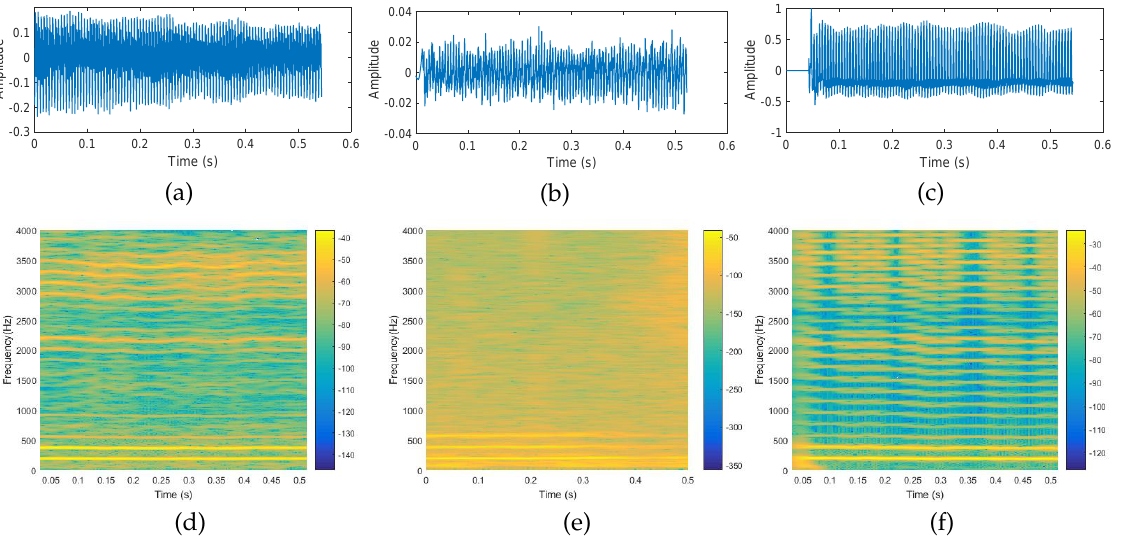
Figure 10. Speech recovery results for the English letter “A”. ( a ) Waveform of the original speech signal; ( b ) waveform of the radar signal; ( c ) waveform of the synthesized speech signal; ( d ) spectrogram of the original speech signal; ( e ) spectrogram of the radar signal; ( f ) spectrogram of the synthesized speech